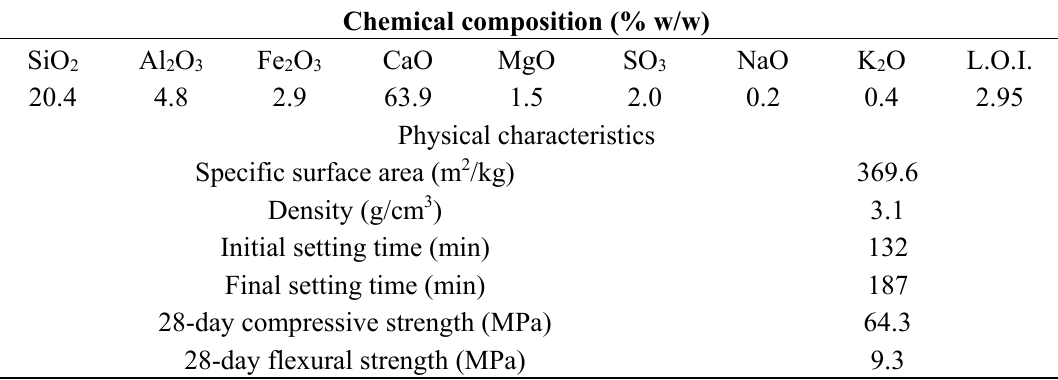
Table 2. The chemical compositions and physical properties of